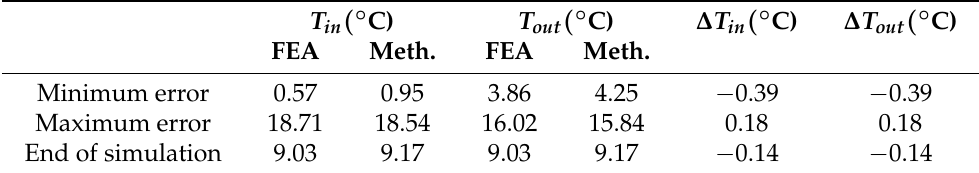
Figure 10. Comparison of predicted inlet and outlet fluid temperatures during the 10th year: ( a ) proposed method, ( b ) FEA model, ( c ) error of the inlet temperature and ( d ) error of the out- let temperature. Table 3. Errors of fluid temperatures during the 10th